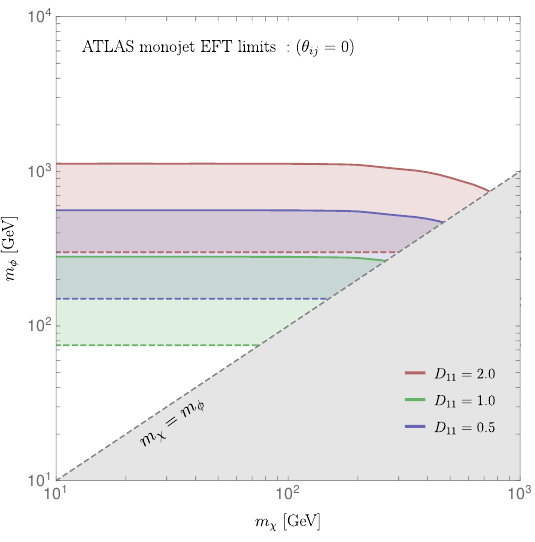
Figure 10 . The EFT approximation breaks down beneath the dashed lines (which are the R contours with g . 4 (cid:25) ), while ATLAS excludes below the solid lines, and so only the shaded regions can robustly be excluded using the EFT.